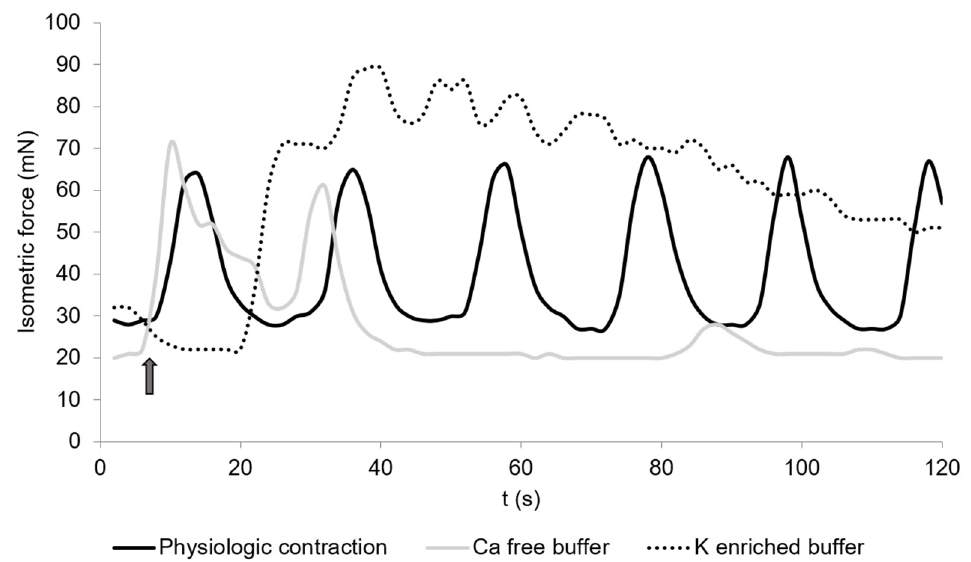
Figure 1. Spontaneous contractions of chicken circular cecal smooth muscle. The control condition is given (physiological contraction, black) and contractions during the incubation in calcium-free buffer (dotted) or potassium-enriched buffer (light grey). The arrow shows the time when the buffers were changed. The contraction was detected for 2 min. The graph is a typical example from a total of 36 measurements.